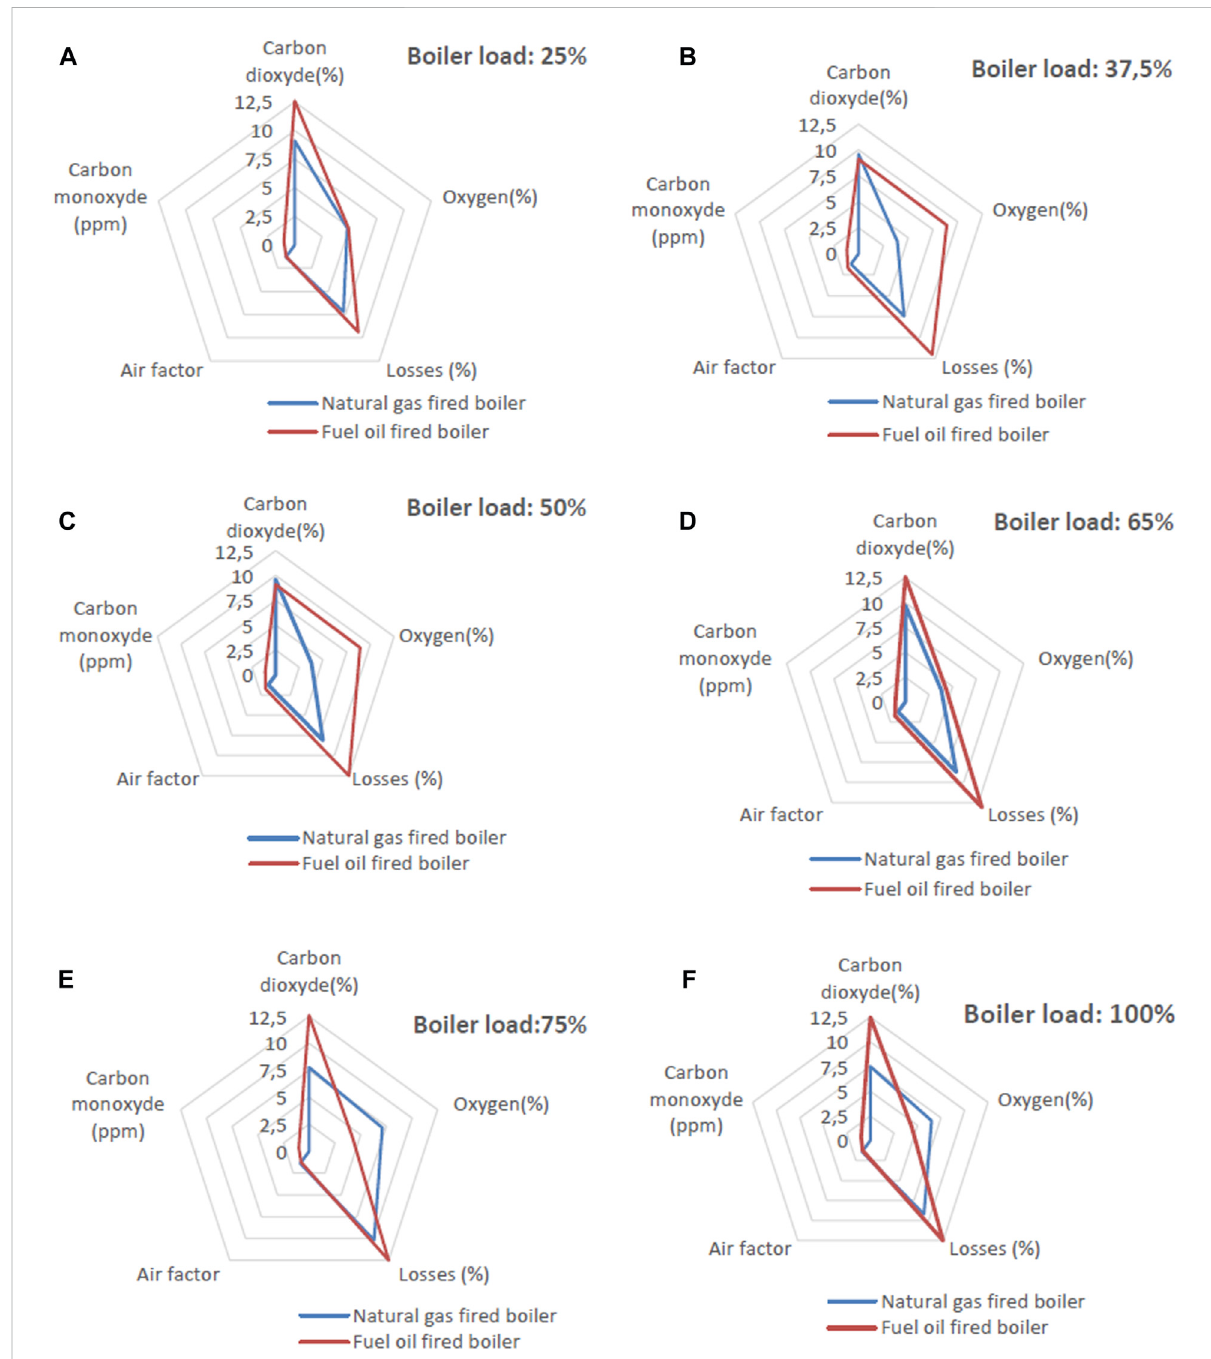
FIGURE 12 Comparison ofcarbondioxide, carbon monoxide, oxygen, air factor, and losses infuel fi ringorgas fi ringmode: (A) boiler load of 25%, (B) boiler load of 37.5%, (C) boiler load of 50%, (D) boiler load of 65%, (E) boiler load of 75%, (F) boiler load of